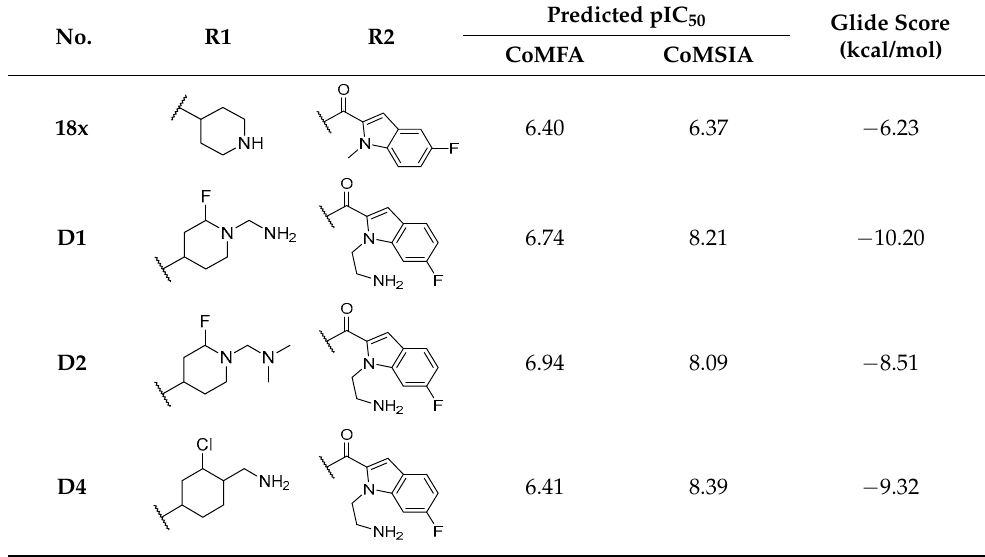
Table 4. The structure, predicted activity and docking score of the newly designed derivatives.